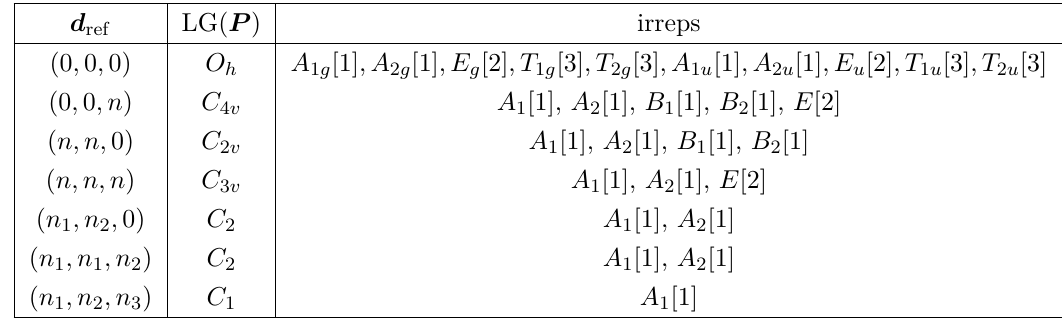
Table 1. Little group LG ( P ) for each type of frame, along with its irreps, each with its dimension listed in square brackets. Frames are denoted by d each type of frame. The integers n , n